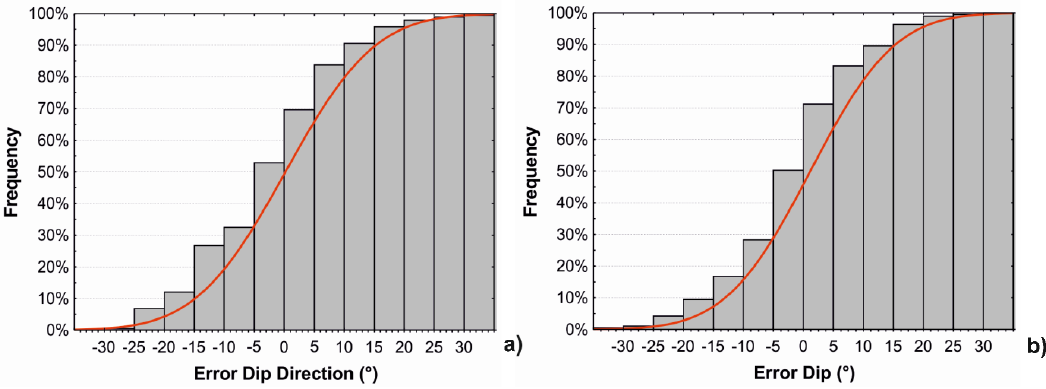
Figs. 3a and 3b Fig. 3. Error tests between indirect estimations and direct measurements (191 samples derived from two test areas) of dip direction (a) and dip of planar discontinuities (b) . Test areas are shown in Fig.